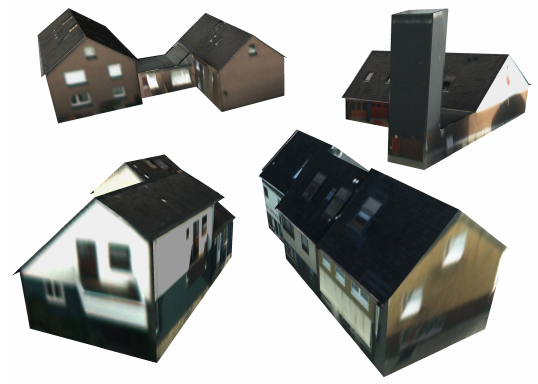
Figure 6. Textured buildings with discontinuities, roof overhangs